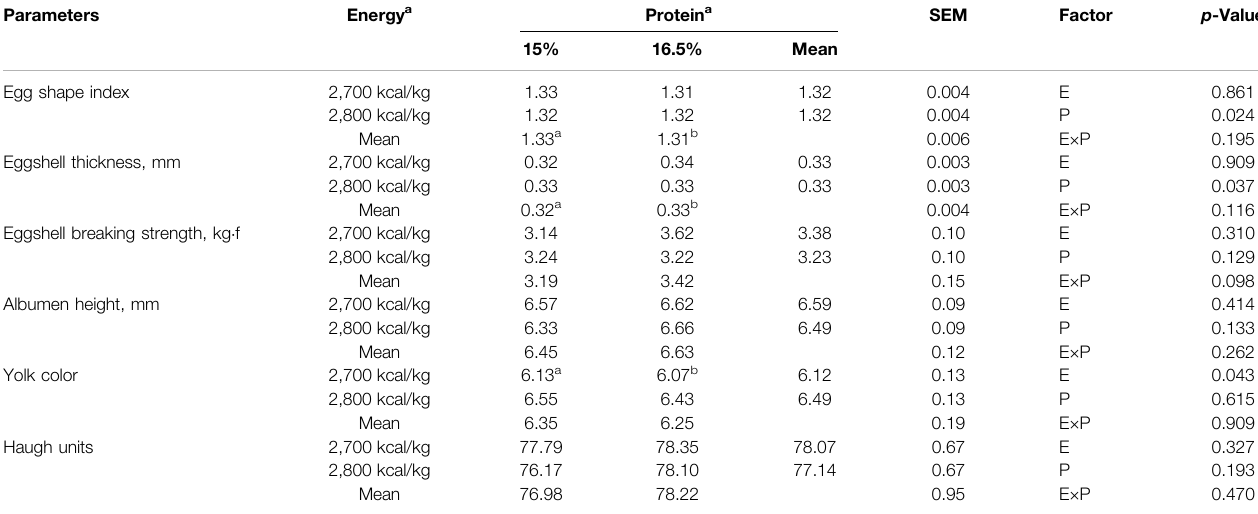
TABLE 4 | Effect ofdietary metabolizable energy (E) and crude protein (P) levels during the prelay period (15 – 20 weeks of age) on egg quality of laying hens at 72 wk of age.